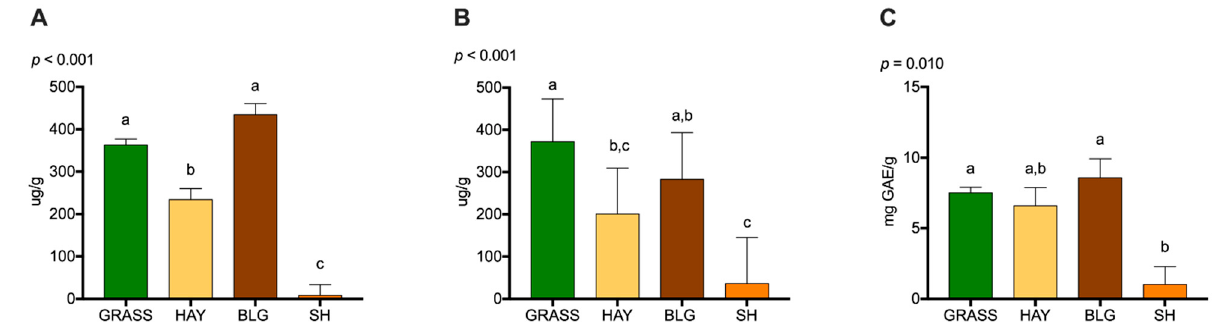
Figure 2. Phytochemical content of feeds. Chlorophyll A ( A ), chlorophyll B ( B ), and total phenols ( C ) found in feed samples. Values reported at means ± standard error. Different letters denote statistical significance at p < 0.05 (mixed model analysis, post hoc comparison performed using Tukey’s adjustment, n = 126 for GRASS, n = 8 for each of the other feeds). GRASS: fresh pasture; HAY: dry